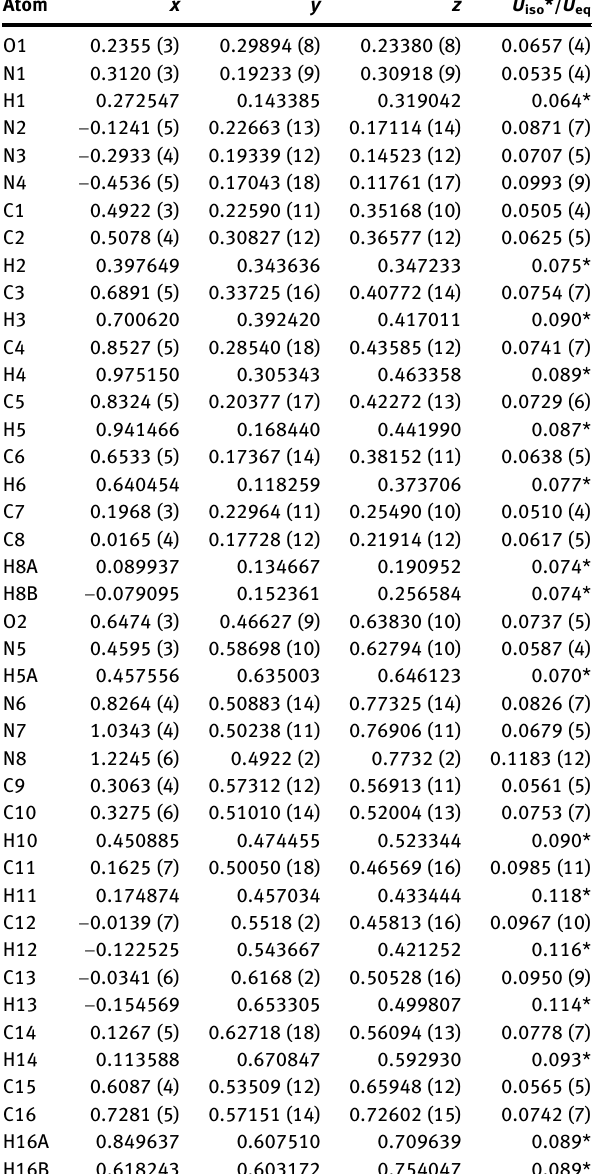
Table  : Fractional atomic coordinates and isotropic or equivalent isotropic displacement parameters (Å  ).